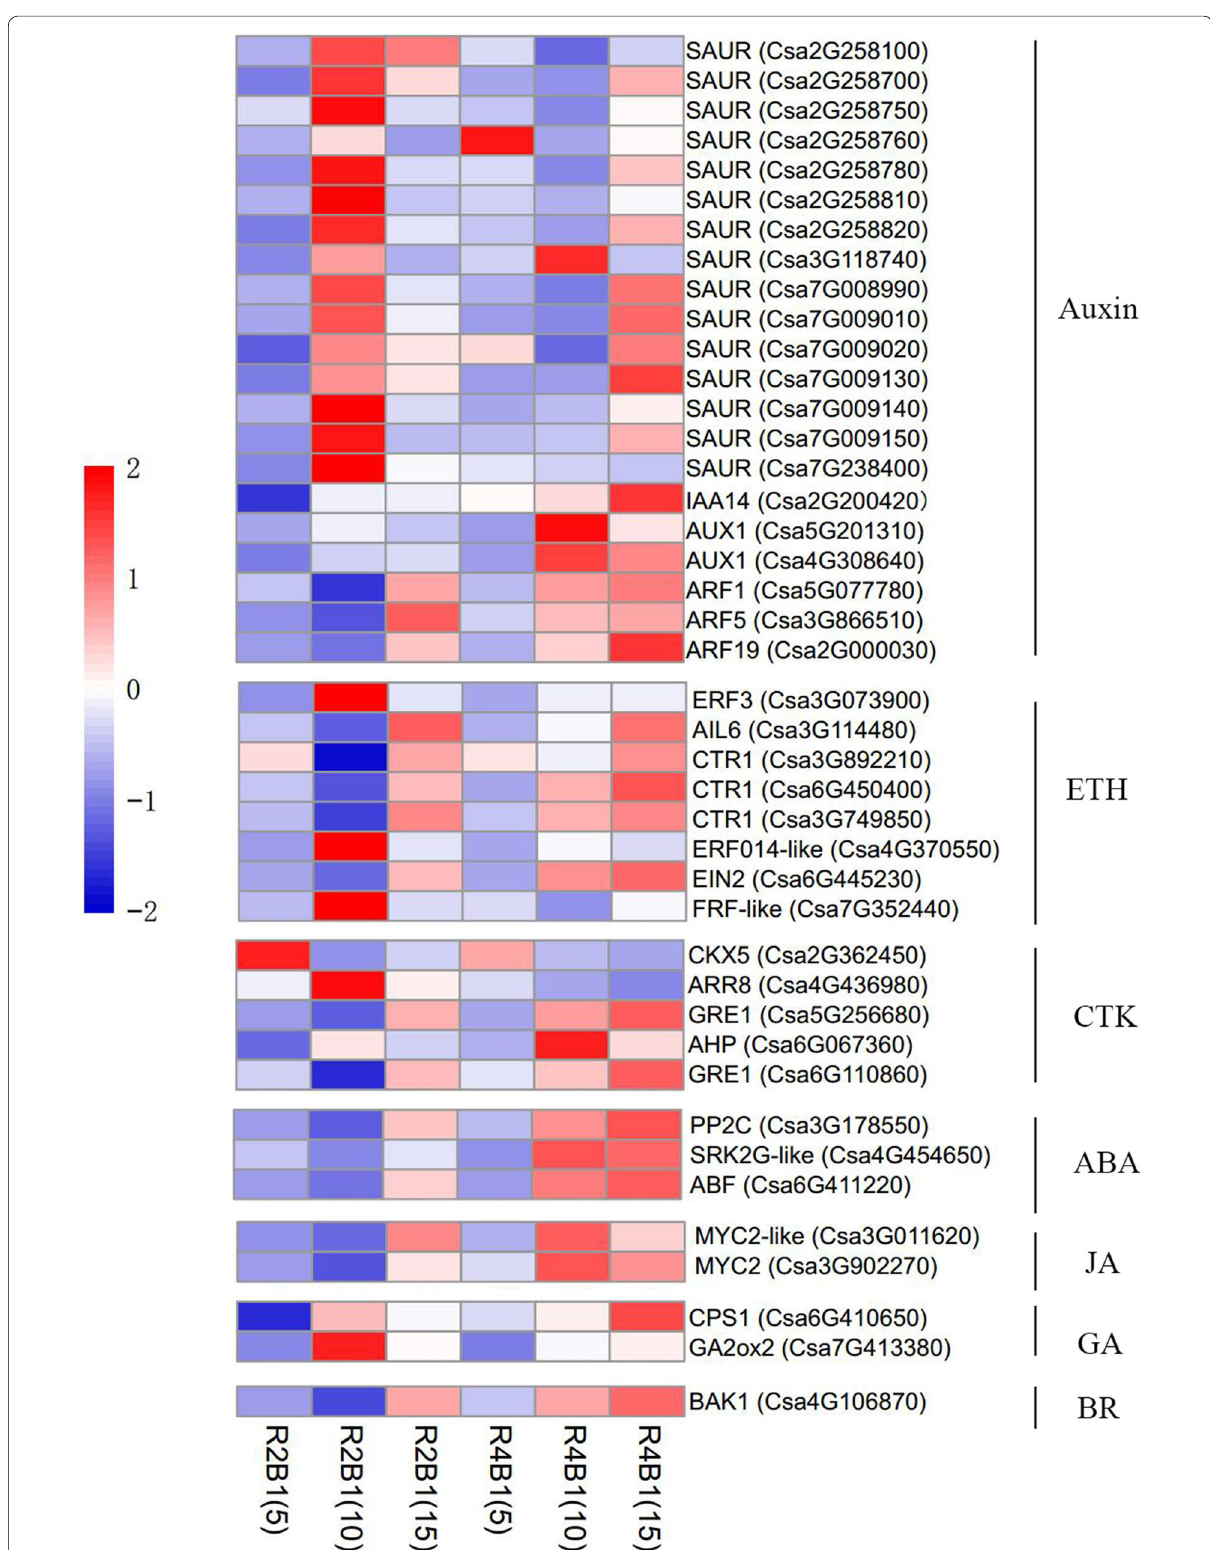
Fig. 6 The expression of a number of genes altered in cucumber shoot apices under different light quality treatments: genes involved in plant hormone signaling